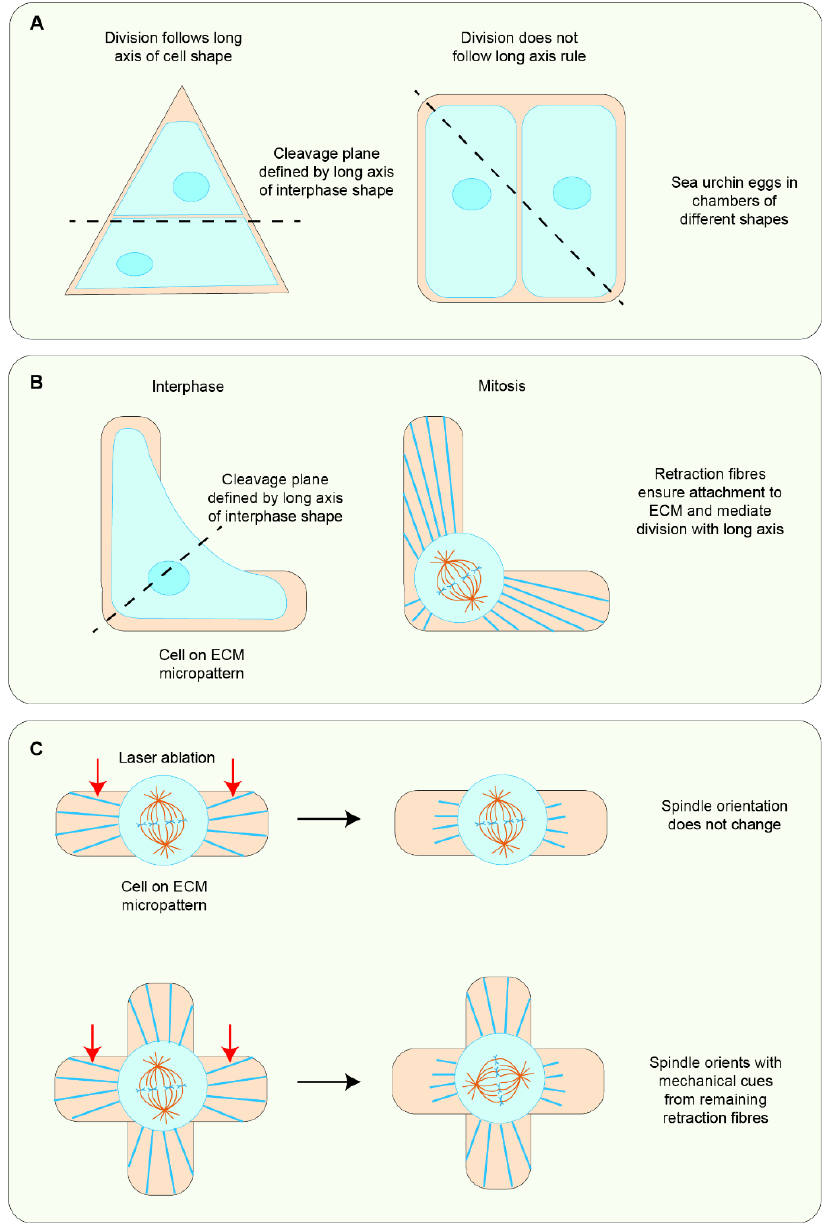
Figure 4. Contribution of cell shape and force in spindle orientation. ( A ) Cells placed in a micro- fabricated chamber assume the shape of the chamber but do not always follow the long axis rule of division. ( B ) Attachment of cells to the ECM via retraction fibres conserves the placement of cortical cues enabling division with the long axis of shape in rounded mitotic cells. ( C ) Using laser ablation to cut some retraction fibres leads to spindle alignment with cortical cues defined by the remaining retraction fibres.